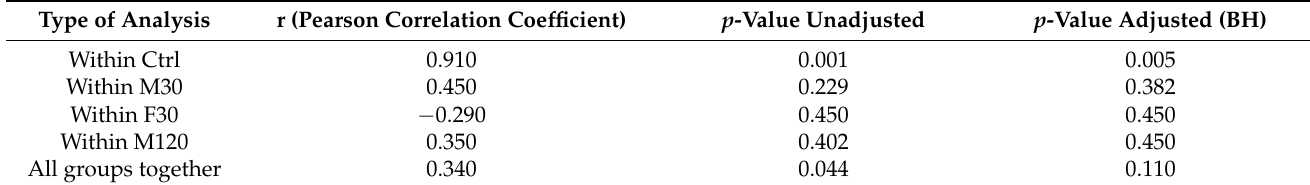
Table 1. Correlation between serum HDL-C [mg/dL] and EL [pg/mL] concentrations.